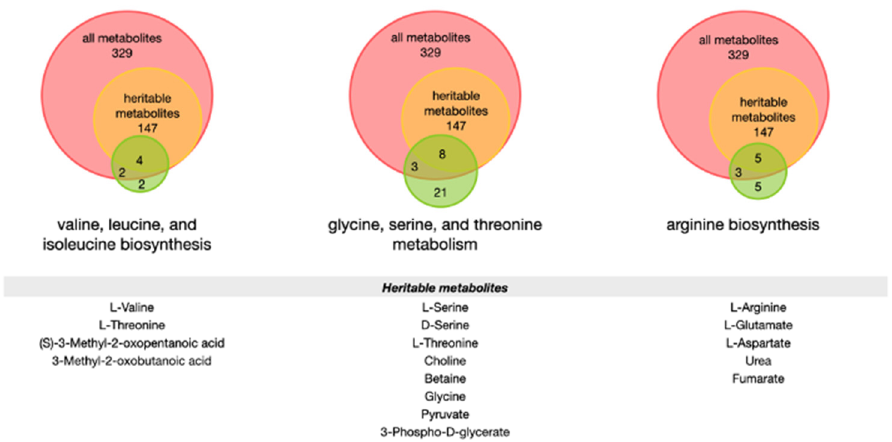
Figure 4. Distribution of heritable vs. non-heritable metabolites involved in amino acid metabolism pathways. Diagrams show the distribution of metabolites involved in valine, leucine, and isoleucine biosynthesis; glycine, serine, and threonine metabolism; and arginine biosynthesis compared to the metabolites present in the erythrocyte metabolomics dataset. Metabolites are classified as heritable ( ≥ 30% heritability) or non-heritable (“all metabolites”), or not present in the twin erythrocyte data set. Diagrams are not drawn to scale.